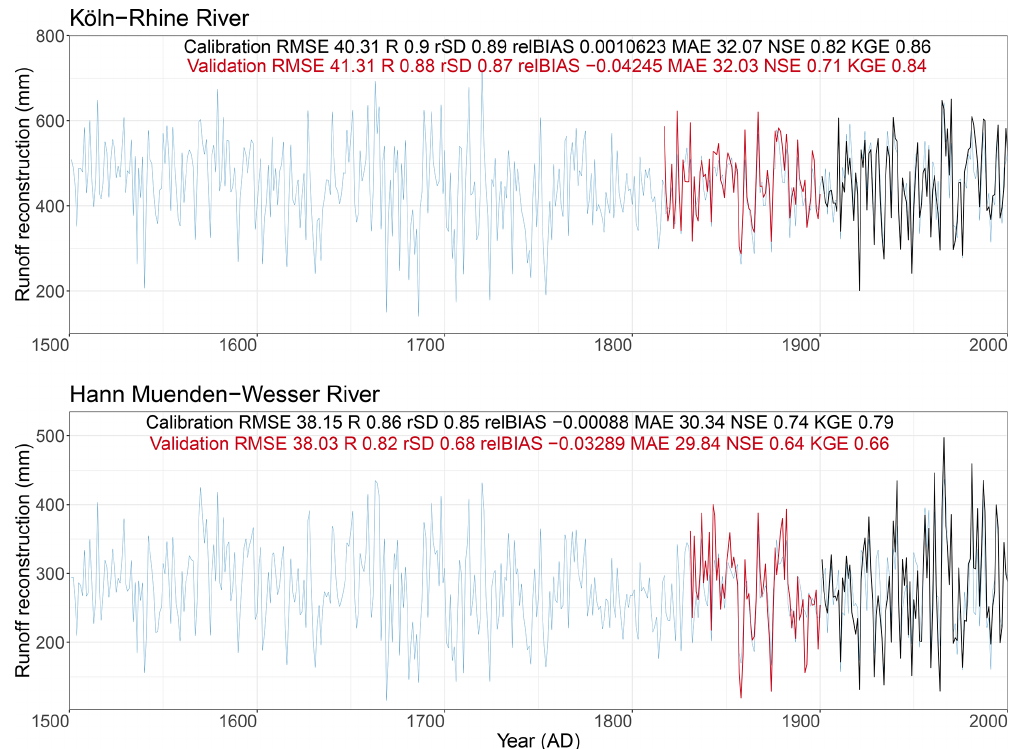
Figure 8. Reconstruction of runoff series for Köln–Main and Hann. Münden Wesser rivers. The blue line corresponds to the reconstructed series, and the black and red lines represent the observed runoff for the calibration and validation period,